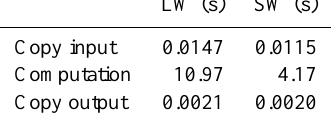
Table 6. The computation time (in seconds) and the speed improve- ment (’ × ’ column) for FAMOUS, the long-wave (LW), and short- wave (SW) radiation for the original version of the radiation algo- rithm on the Intel Core i7 Q720 and the OpenCL version running on the Nvidia GeForce GT